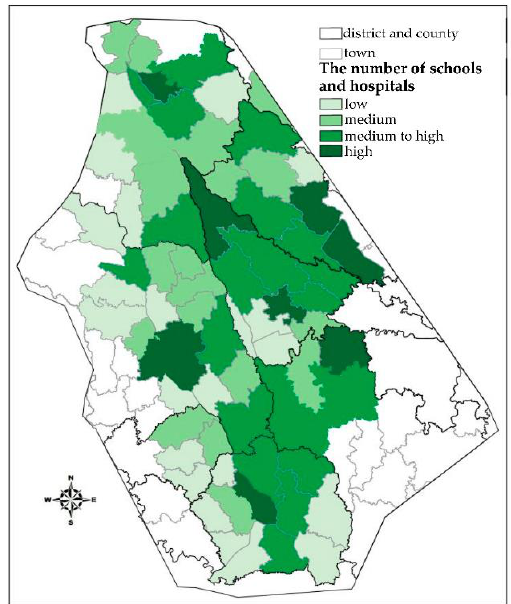
Figure 8. Number of hospitals and schools in each